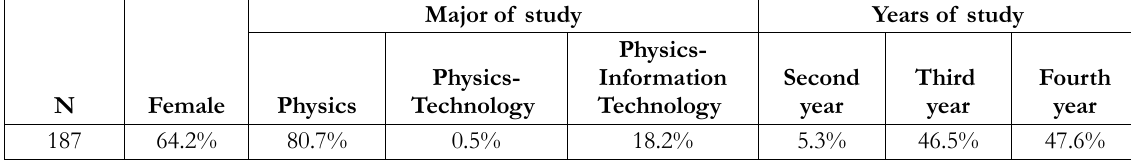
Table 1. Information of sampled pre-service teachers